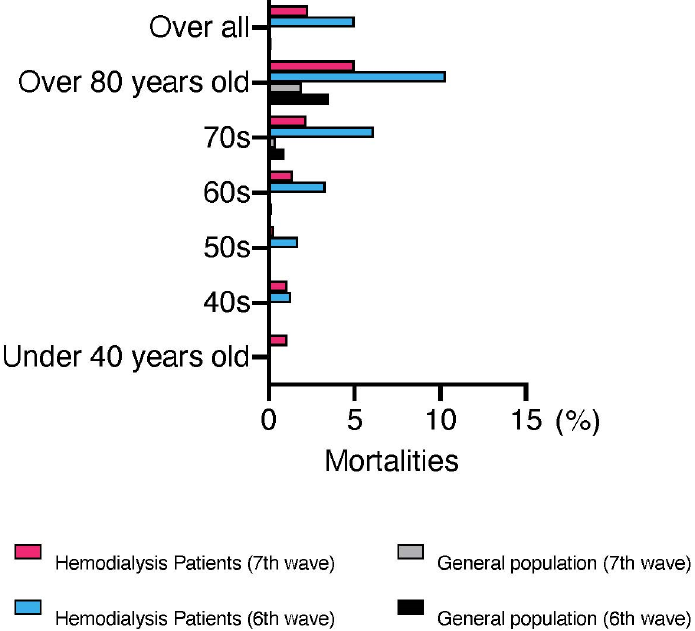
Figure 2. Mortalities in the general population and patients undergoing dialysis after the sixth wave. This figure was drawn from the 9 November 2022 report of the Advisory Board for New Coronavirus Infections (https://www.mhlw.go.jp/content/10900000/001010896.pdf, accessed on 7 December 2022) and the “Report on COVID-19 Infection Cases at Dialysis Facilities” jointly published by the Japanese Association of Dialysis Physicians, the Japanese Society for Dialysis Therapy, and the Japanese Society of Nephrology. This figure is accurate as of 7 December 2022.